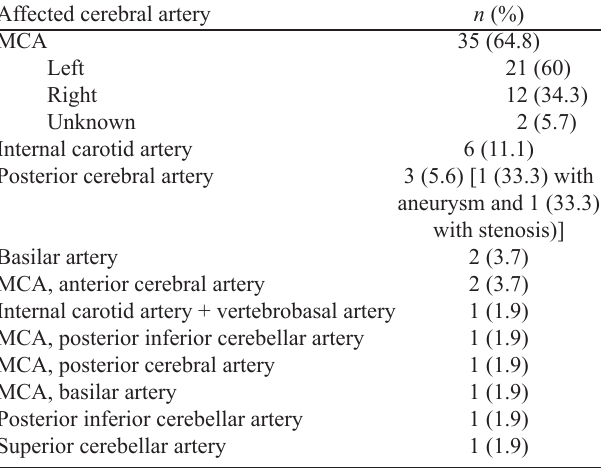
Table 5. The affected cerebral artery in 54 patients.